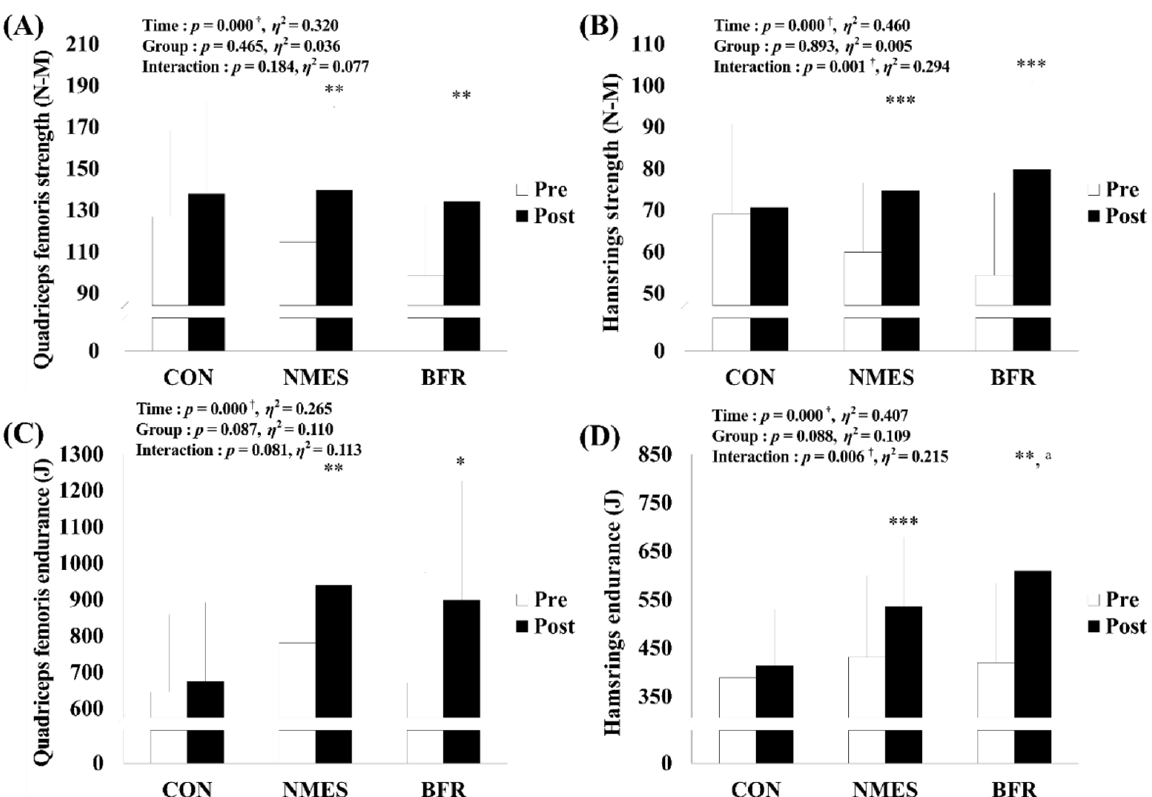
Figure 5. Changes in isokinetic muscle function via rehabilitation intervention in each